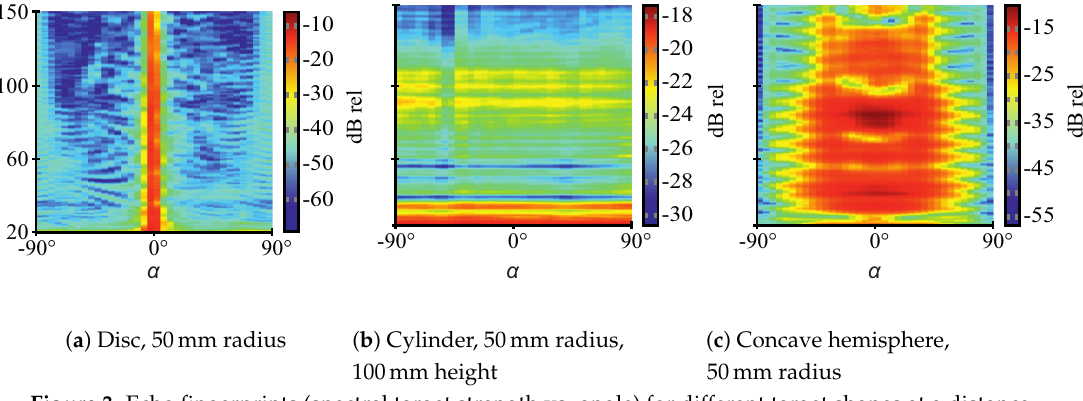
Figure 3. Echo fingerprints (spectral target strength vs. angle) for different target shapes at a distance of